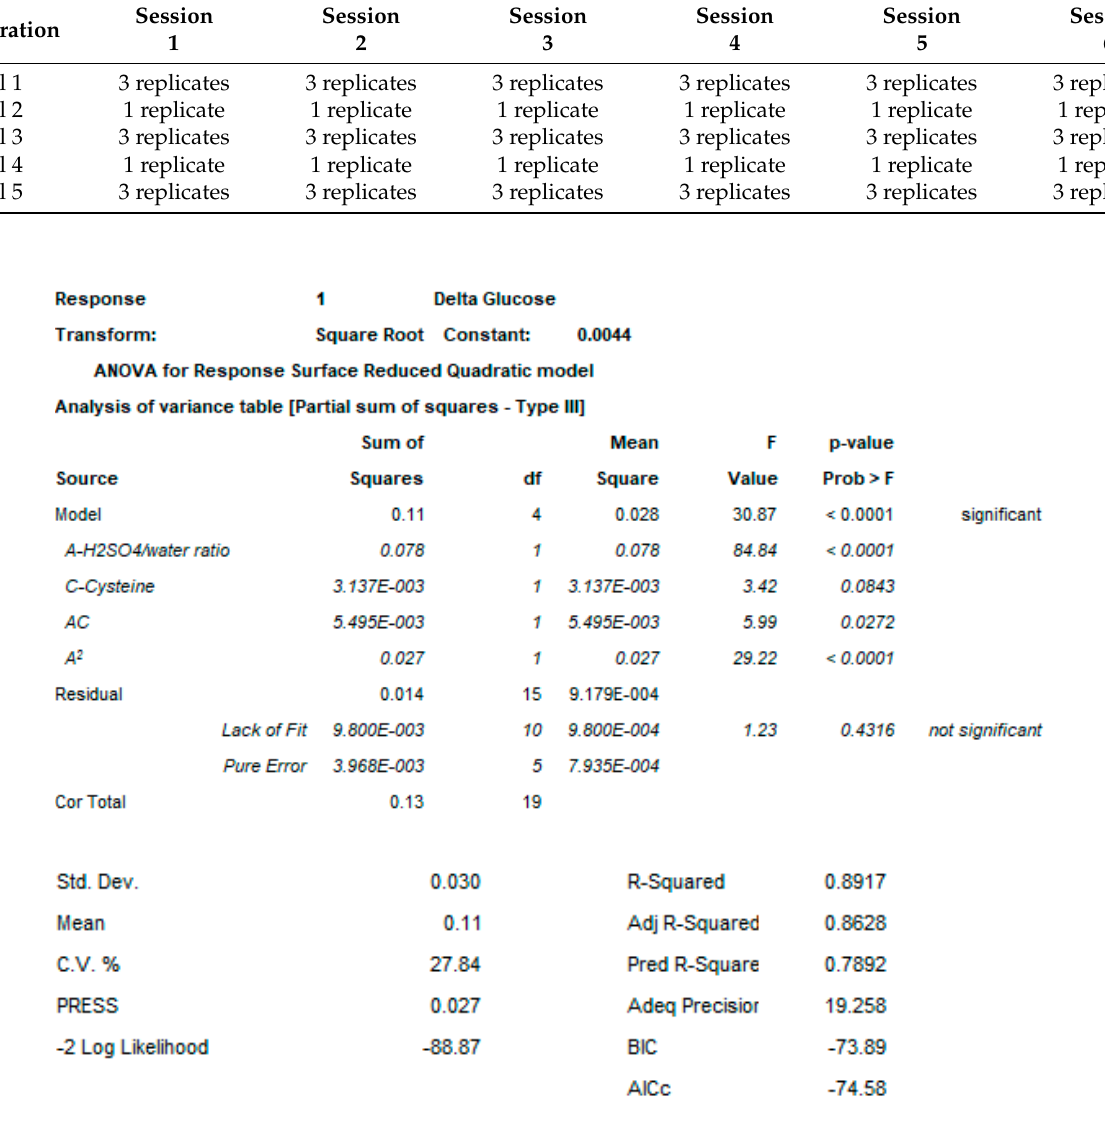
Figure A1. DoE statistical analysis for glucose response surface in Dische colorimetric method.